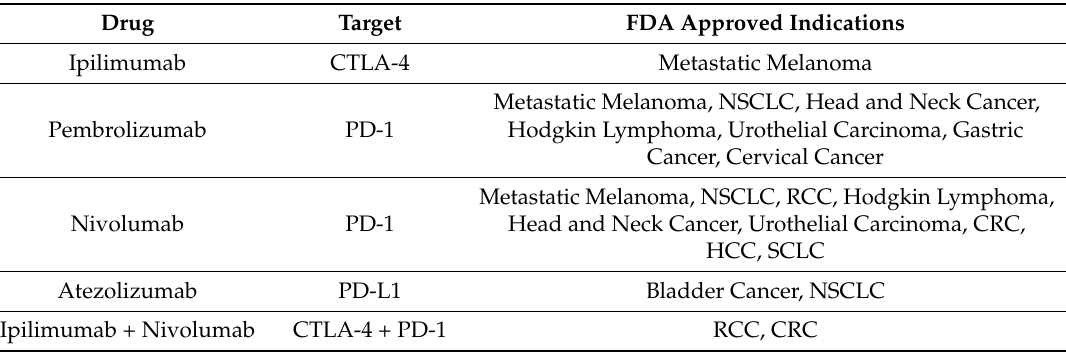
Table 1. Immune checkpoint inhibitors and